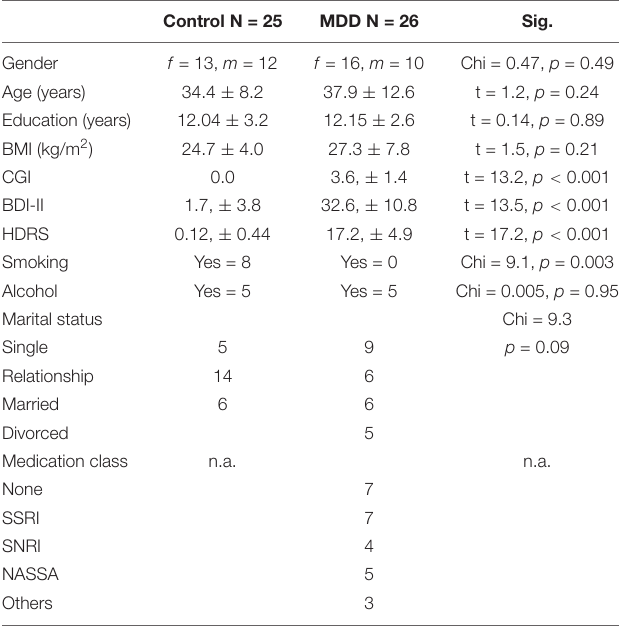
( Table 1 ). Per definition, patients with MDD show significant higher depression severity compared to healthy controls.